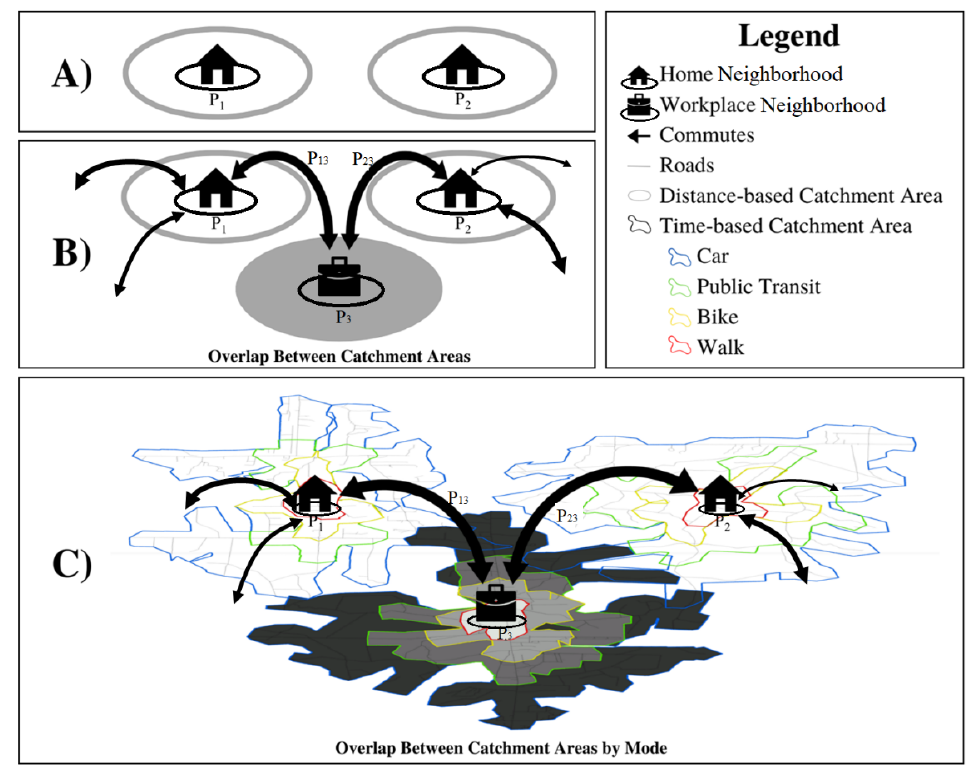
Figure 1. An illustration and comparison of food catchment areas defined by ( A ) the traditional mRFEI assuming people access food only from homes, ( B ) MO_RFEI with people accessing food from both home and workplace due to commuting, and ( C ) eRFEI with people accessing food from multiple origins and travel modes. Shaded areas show where the catchment areas of two populations overlap. Colored borders delineate catchment areas of different travel models.